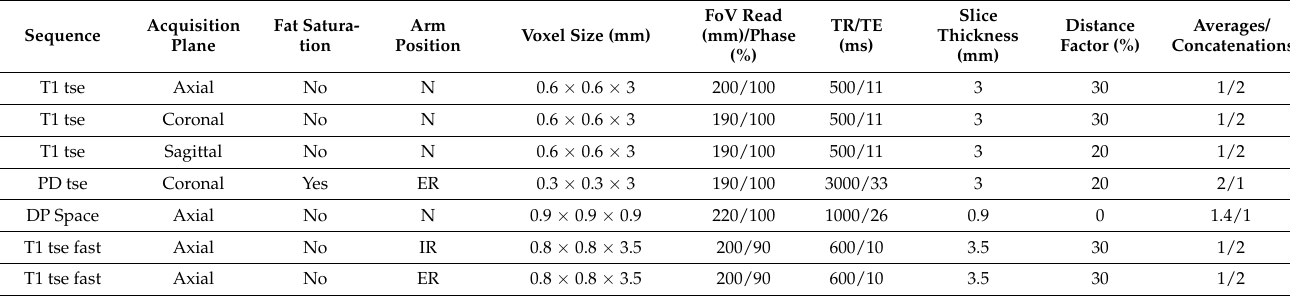
Table 1. MRA acquisition protocol.